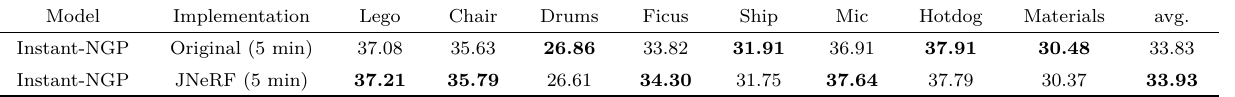
Table 1 PSNR (dB) achieved by JNeRF implementation and the original implementation of Instant-NGP